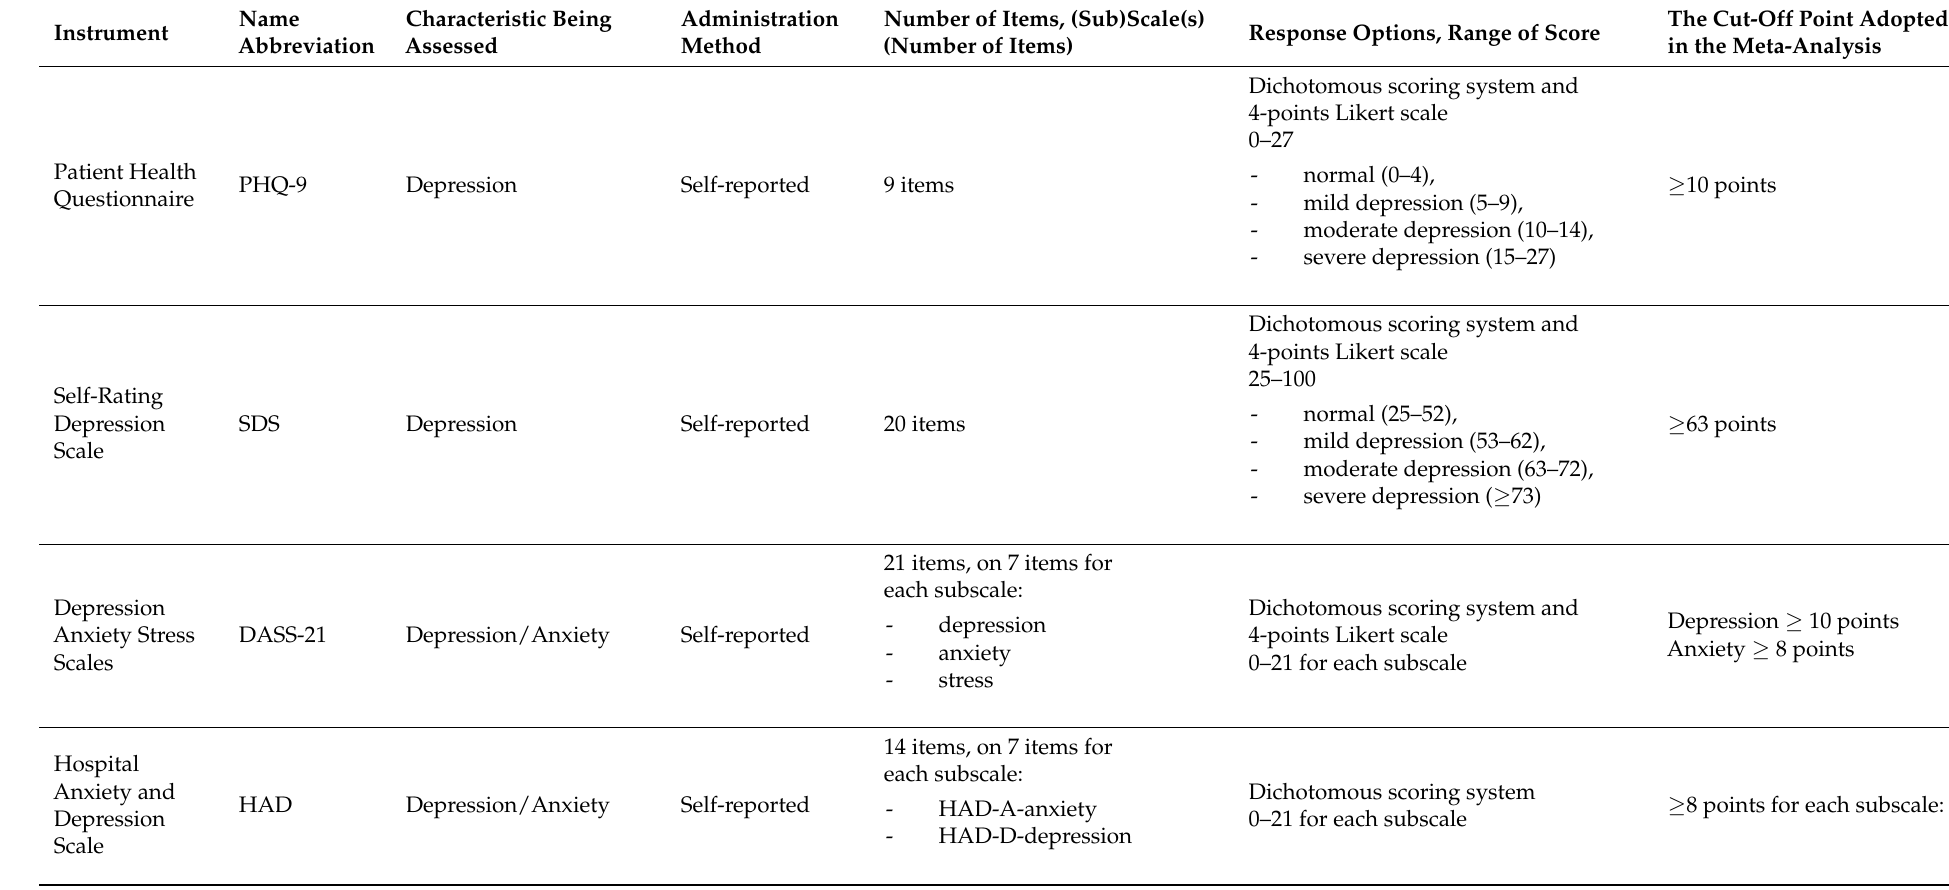
Table 2. Characteristics of research tools used in assessing depression and anxiety